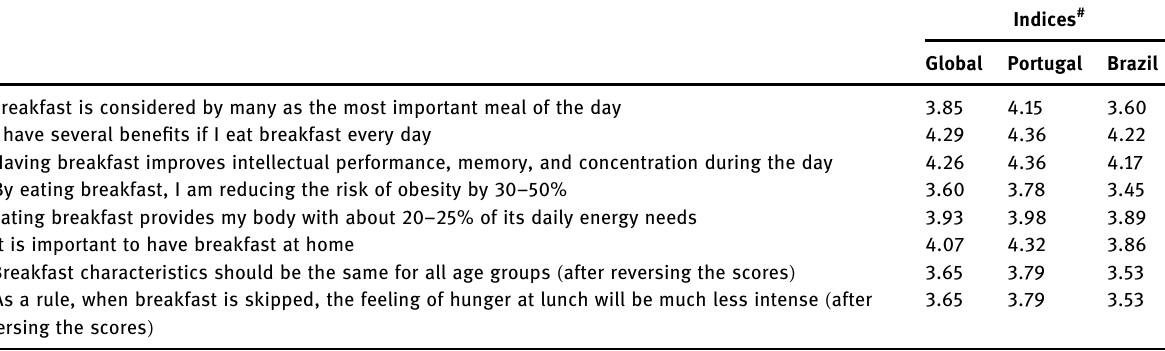
Table 4: Indices for items used to evaluate knowledge